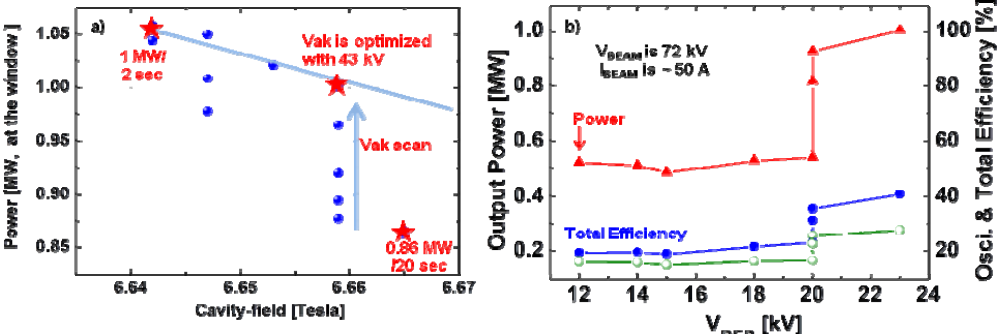
Fig. 2. The beam parameters are optimized by the control of Vak and Bc. a) shows the cavity-field dependence of the gyrotron output and b) shows the depressed collector voltage dependence of the gyrotron putput and